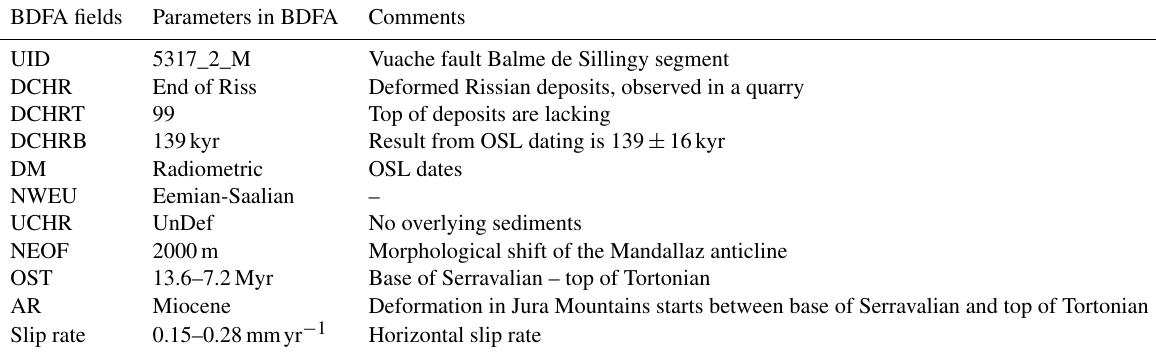
Table 1. BDFA parameters concerning the 5317_2_M segment of the Vuache fault. Data derived from Baize et al. (2011). BDFA